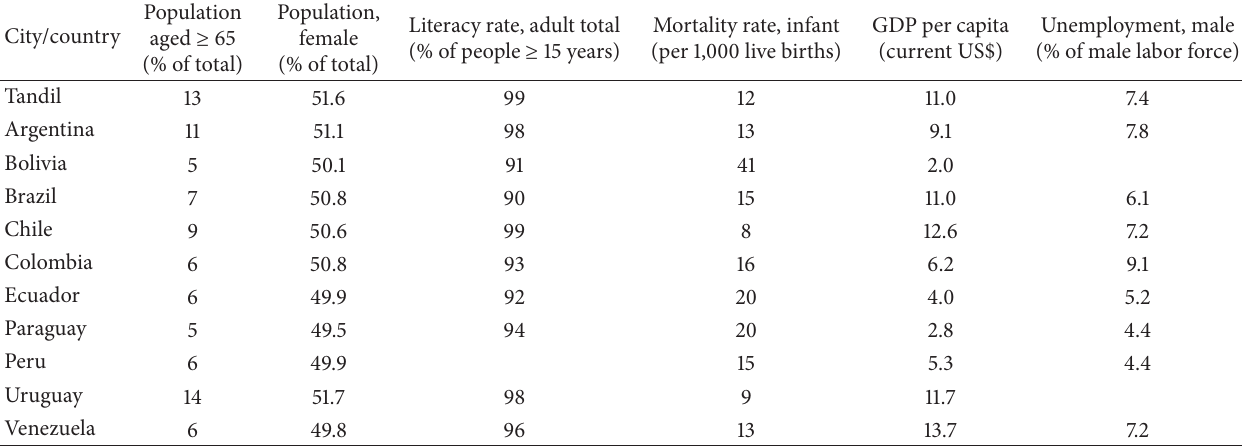
Table 3: Socioeconomic indicators of Tandil city and Latin American countries (year 2010).